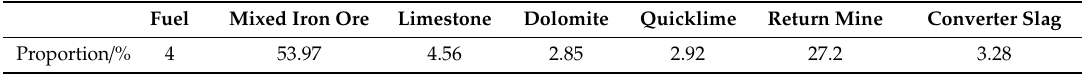
Table 4. Ratios of sintering raw materials [16].